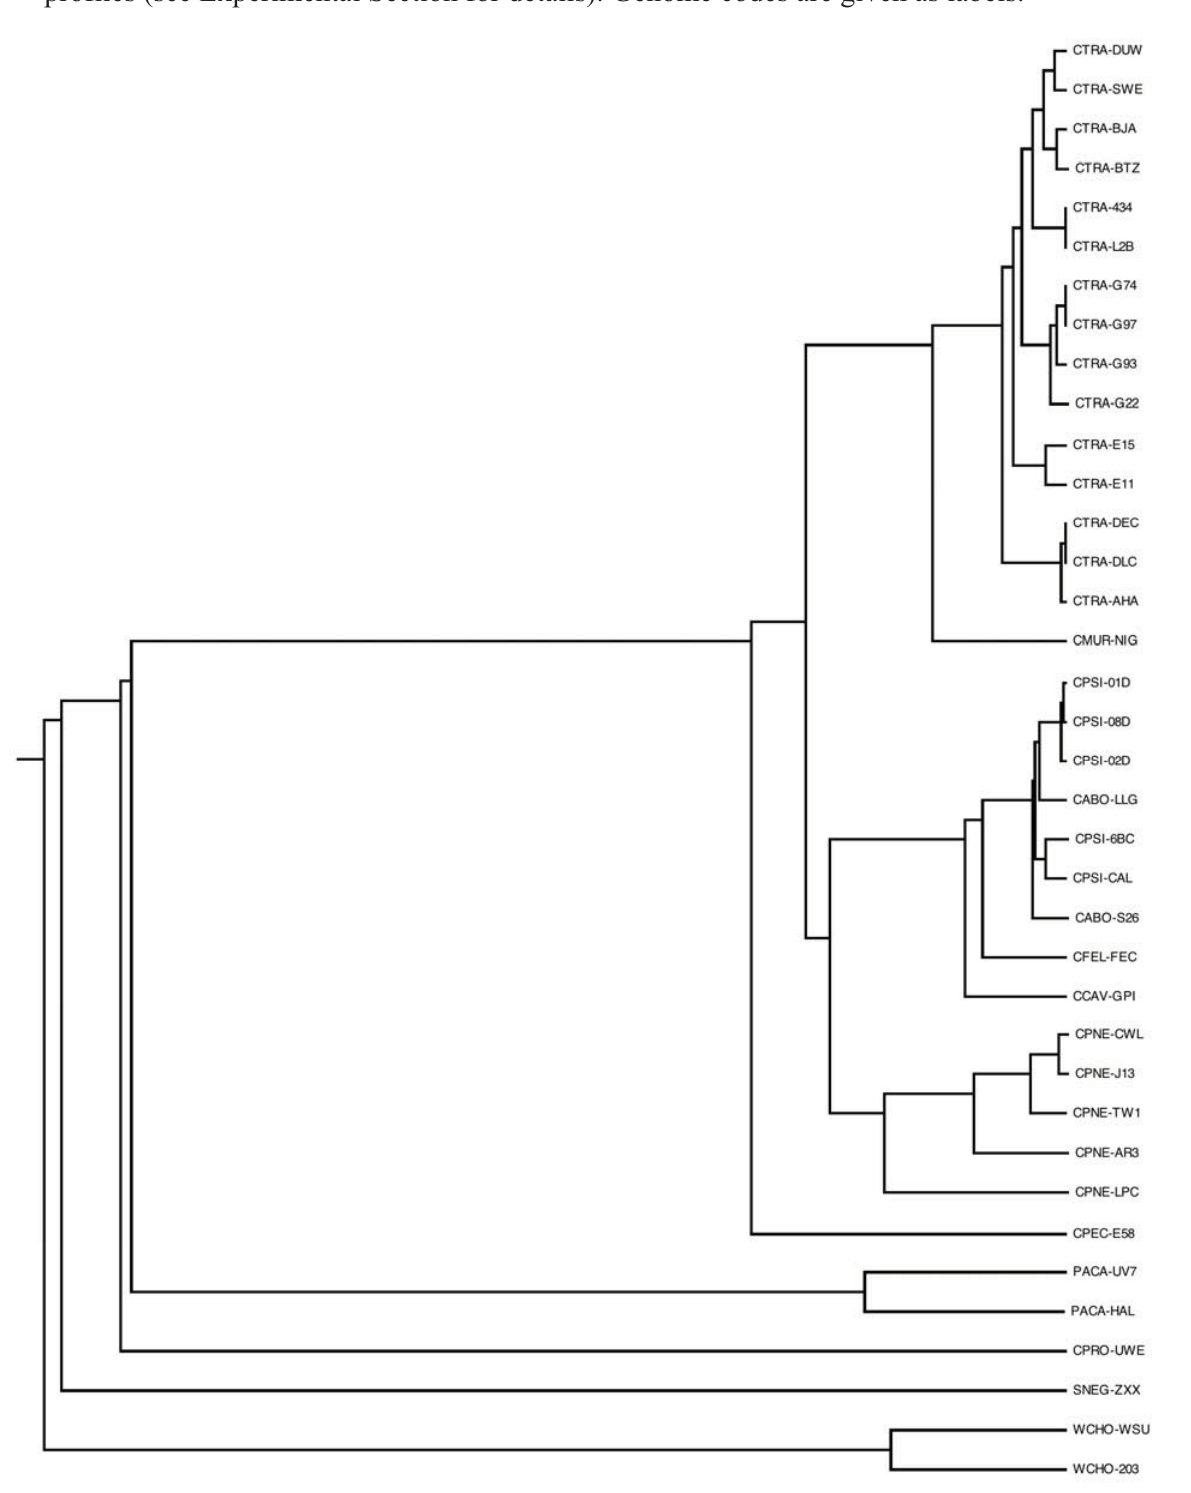
Figure 7. Genome tree of the Chlamydiales . Dendrogram representing phylogenetic relationships of the 37 Chlamydiales genomes analyzed, based on sharing of phylogenetic profiles (see Experimental Section for details). Genome codes are given as